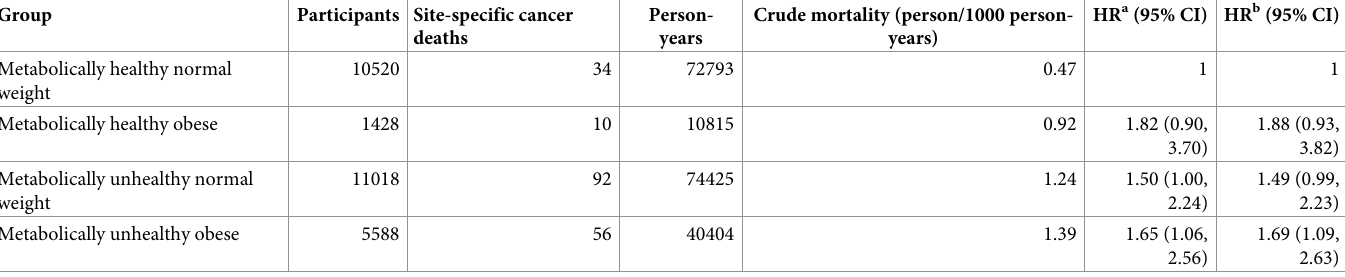
Table 5. Hazard ratios and 95% confidence intervals for total cancer mortality in relation to metabolically healthy status and body mass index (criteria of Japan Society for the Study of Obesity were used, with modification).